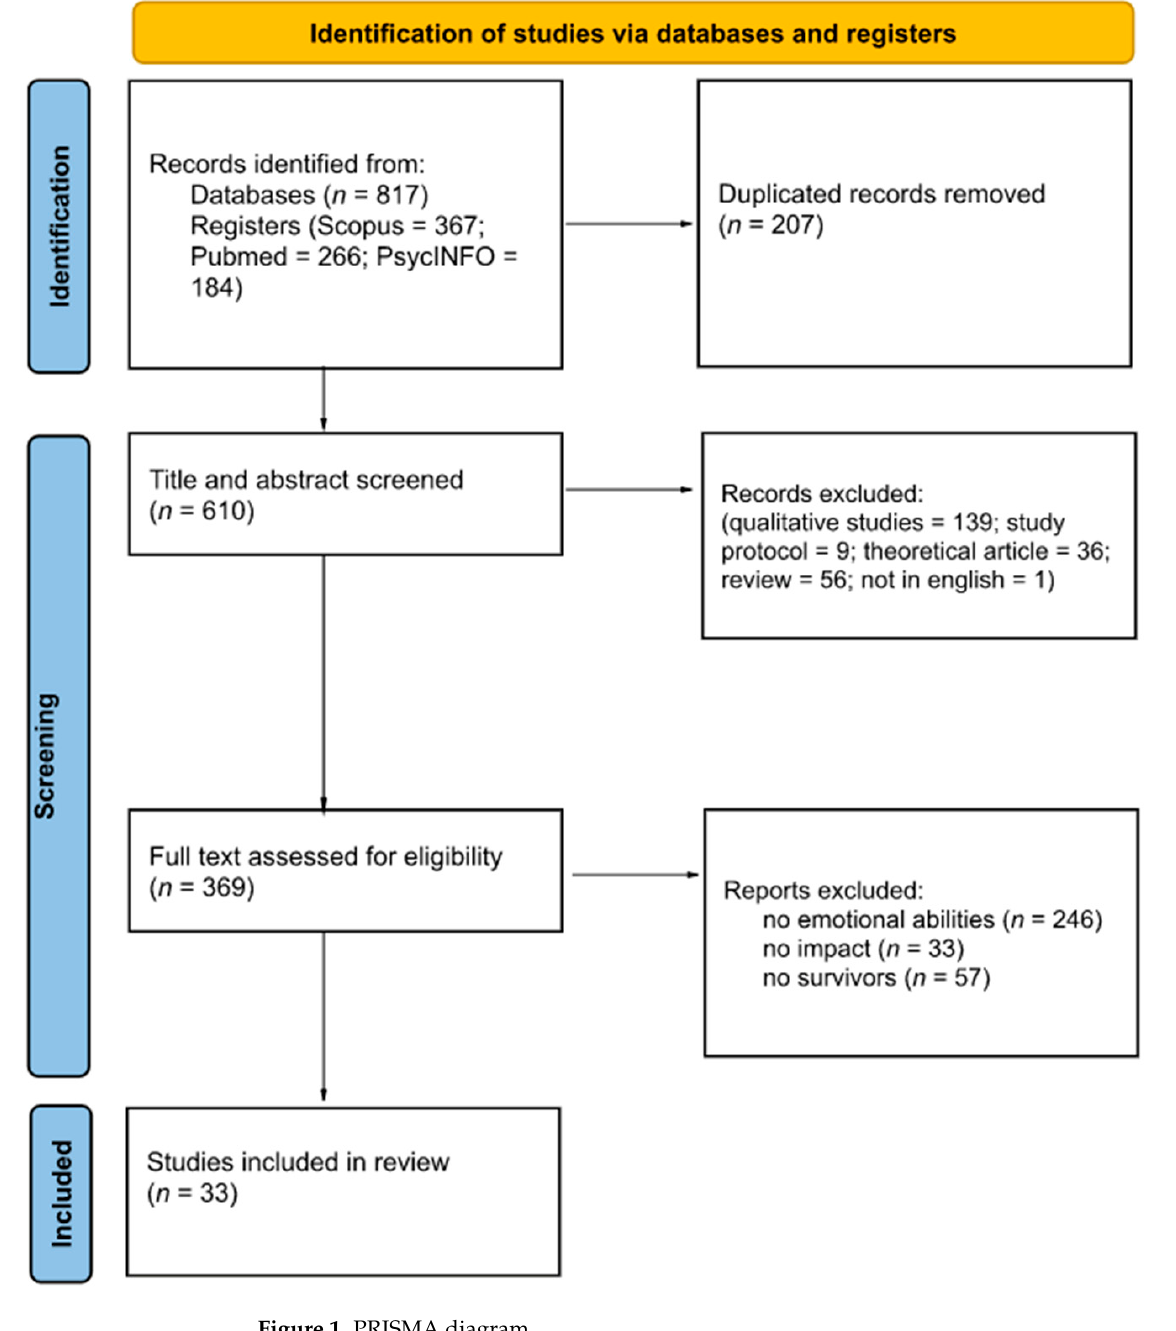
Figure 1. PRISMA Figure 1. PRISMA diagram.